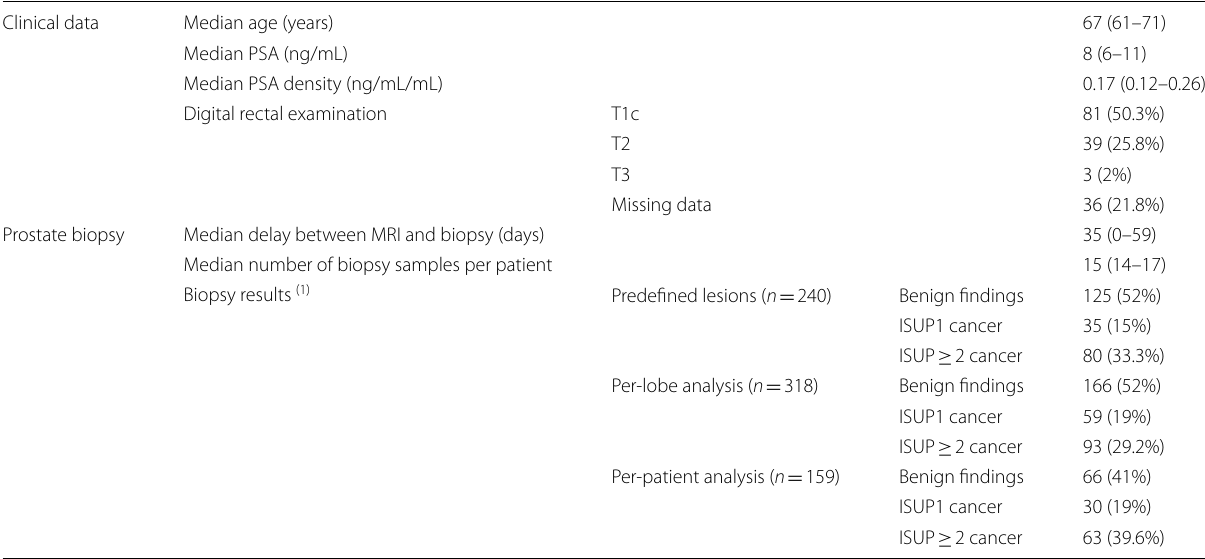
Table 1 Patients’